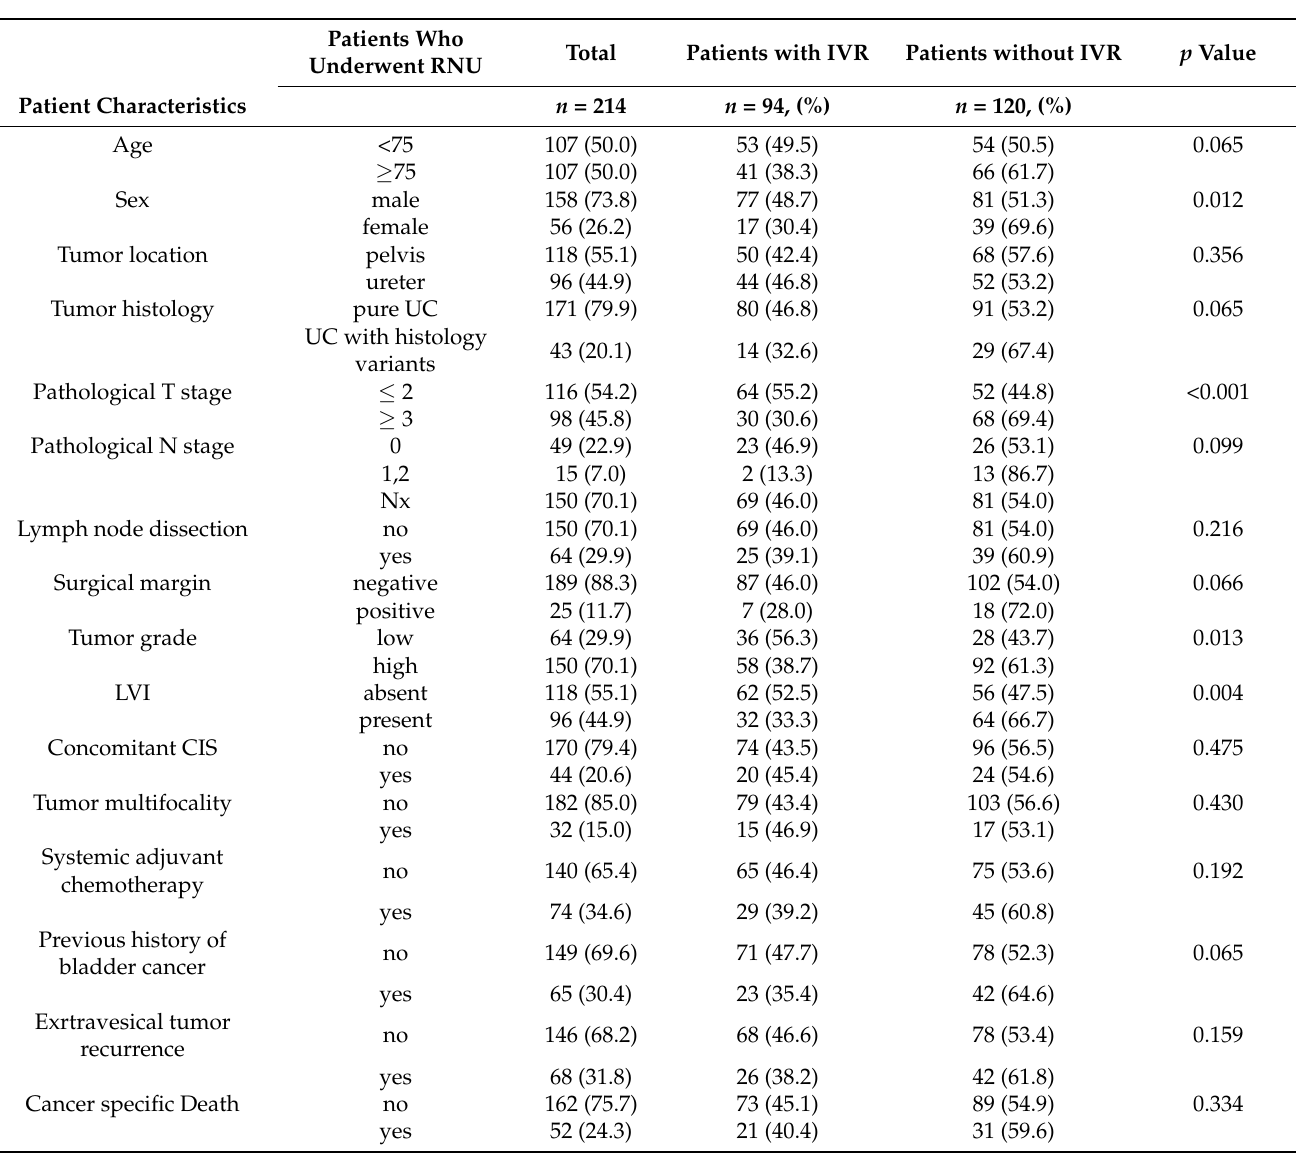
Table 1. Clinicopathological and molecular characteristics of UTUC patients who underwent radical